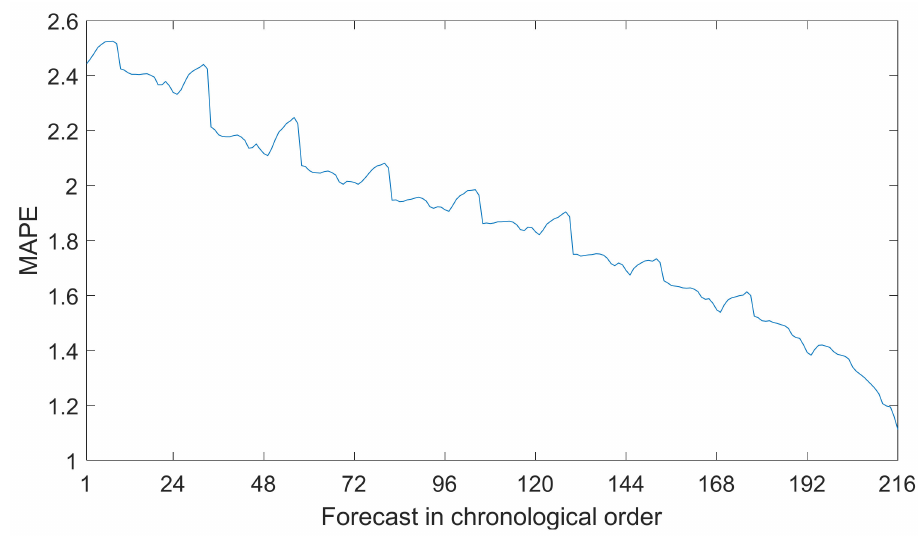
Figure 1. Error of auto-regressive forecasts in